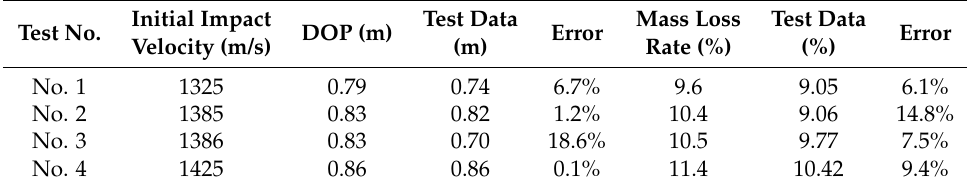
Table 2. Comparison of predicted result with the experimental data.